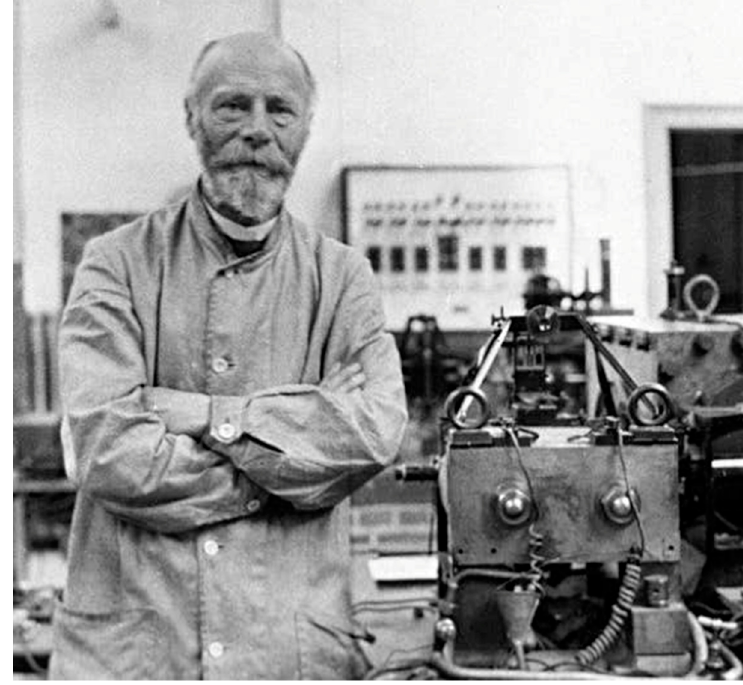
Figure 3. Willem Einthoven alongside his invention, the string galvanometer.